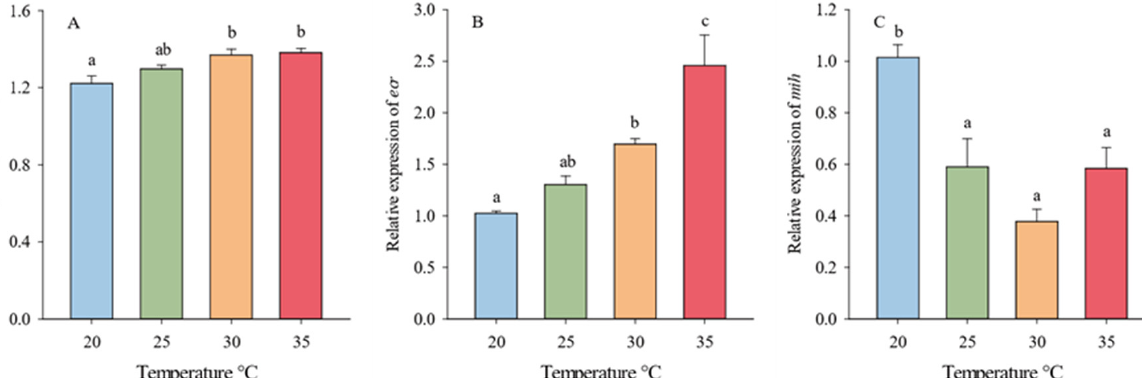
Figure 4. Effects of different temperatures (20-35 °C) on the average daily food intake ( A ) and feed conversion efficiency ( B ) of juvenile mud crabs. Values are expressed as mean ± SD ( n = 3). Different superscripts indicate significant differences between treatments ( p < 0.05).